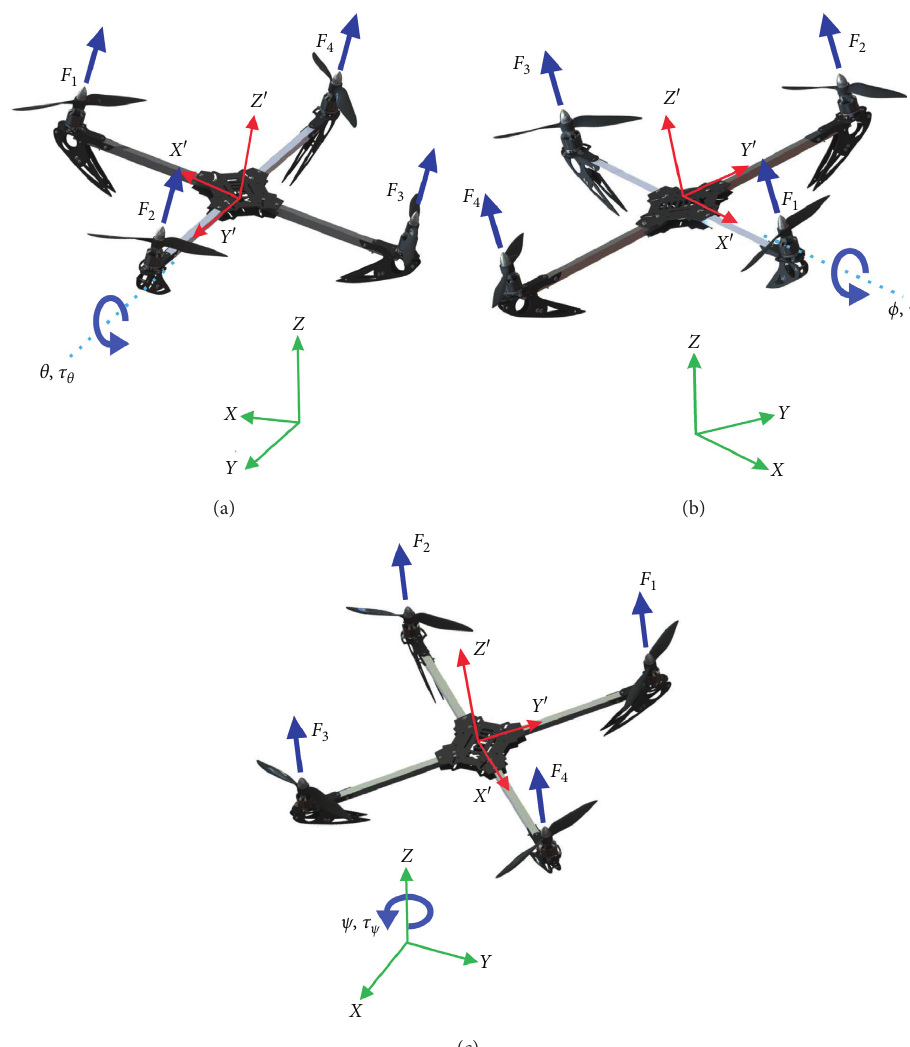
Figure 4: Motion in each direction of the space by the control inputs. (a) Pitching moment. (b) Rolling moment. (c) Yawing